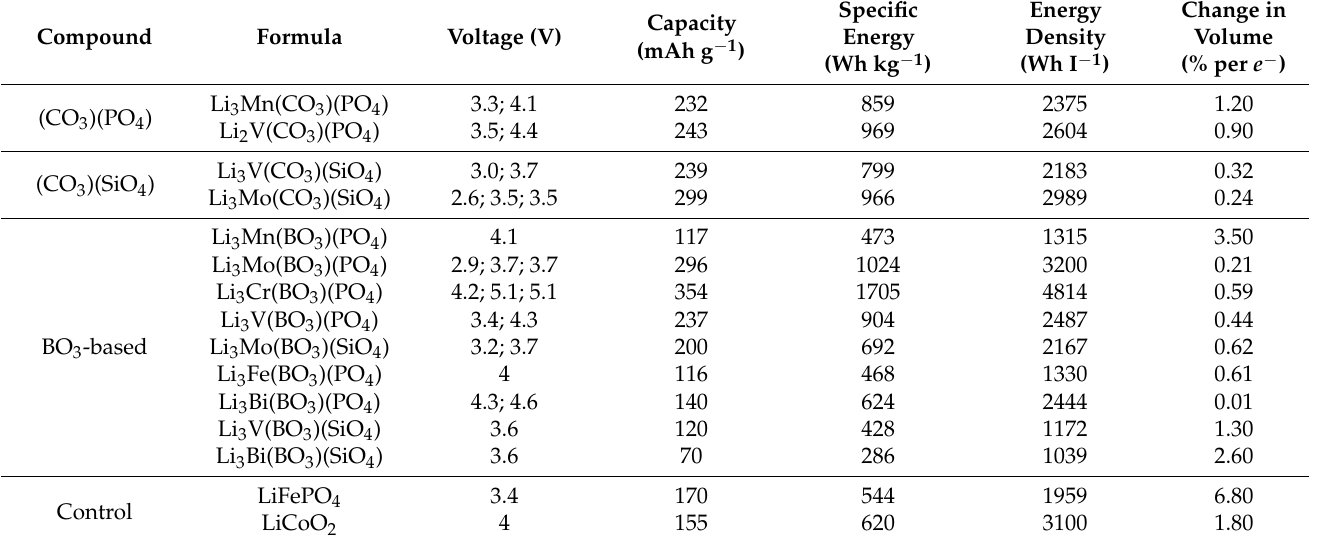
Table 4. Computed LIB properties for the Na-compounds of carbonophosphates [(CO 3 )(PO 4 )] and carbonosilicates [(CO 3 )(SiO 4 )] stable in sidorenkite structure (viz., likely to be synthesizable via Li-Na exchange) as well as that of borate-based compounds close to stability in Na sidorenkite struc- ture (<30 meV at − 1 ) in comparison to two commercial cathode materials (Data retrieved from [19]. Copyright 2011, The Royal Society of